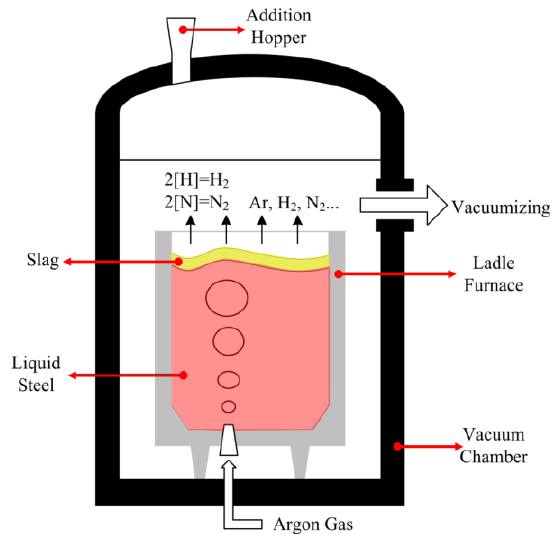
Figure 1. Schematic representation of a VTD.